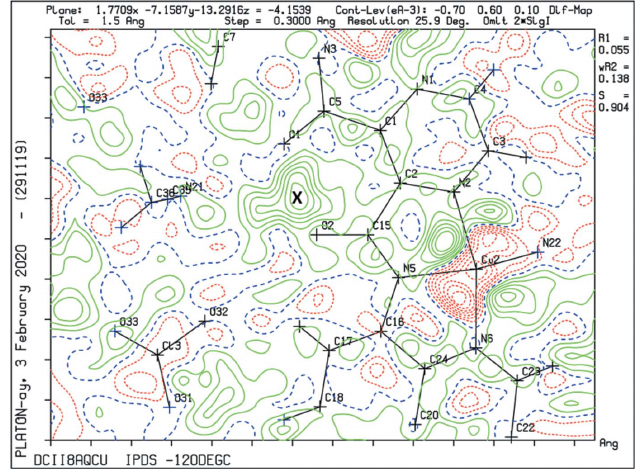
Figure 3 A difference-Fourier map showing the position ( X ) of the hydroxyl H atom, H2 O , in complex I .